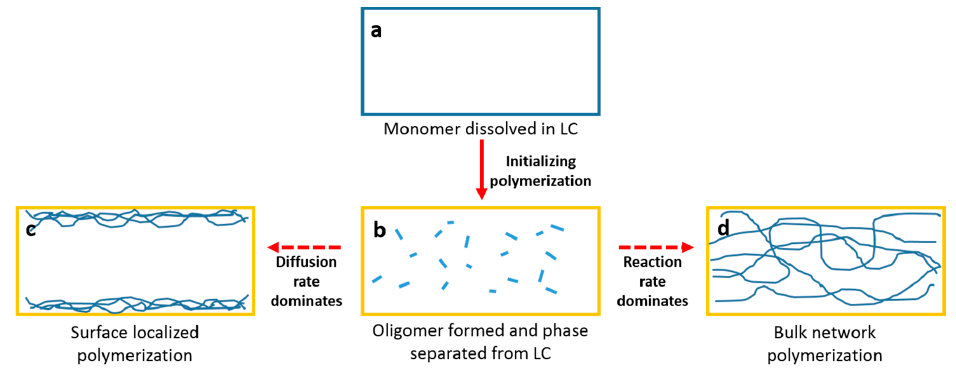
Figure 12. Sketched mechanism for the polymerization of RM from LC solvent: ( a ) RM dissolved in LC before UV exposure; ( b ) Oligomer formed and phase separated from LC after initial UV polymerization; ( c ) Surface localized polymerization and ( d ) bulk network polymerization.